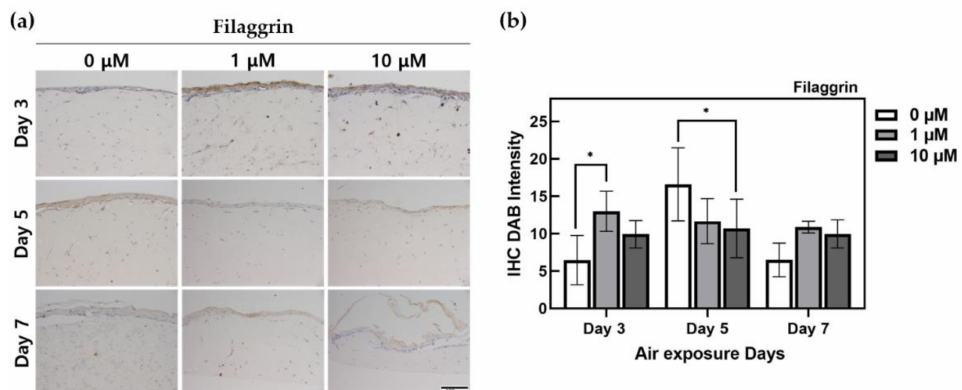
Figure 3. Immunohistochemistry-stained images for filaggrin of HSEs treated α -lipoic acid concentration of 0, 1, and 10 µ M. ( a ) This is the result of filaggrin expressed by IHC staining in HSEs. The x-axis is listed by ALA-treated concentration, and the y-axis is listed by ALA-treated period. The scale bar is 100 µ m. ( b ) This is a graph of quantification of 3,3 (cid:48) -Diaminobenzidine intensity for IHC staining of filaggrin protein using the ImageJ program. ( n = 4; *, p < 0.05 vs. 0 µ M for each period).